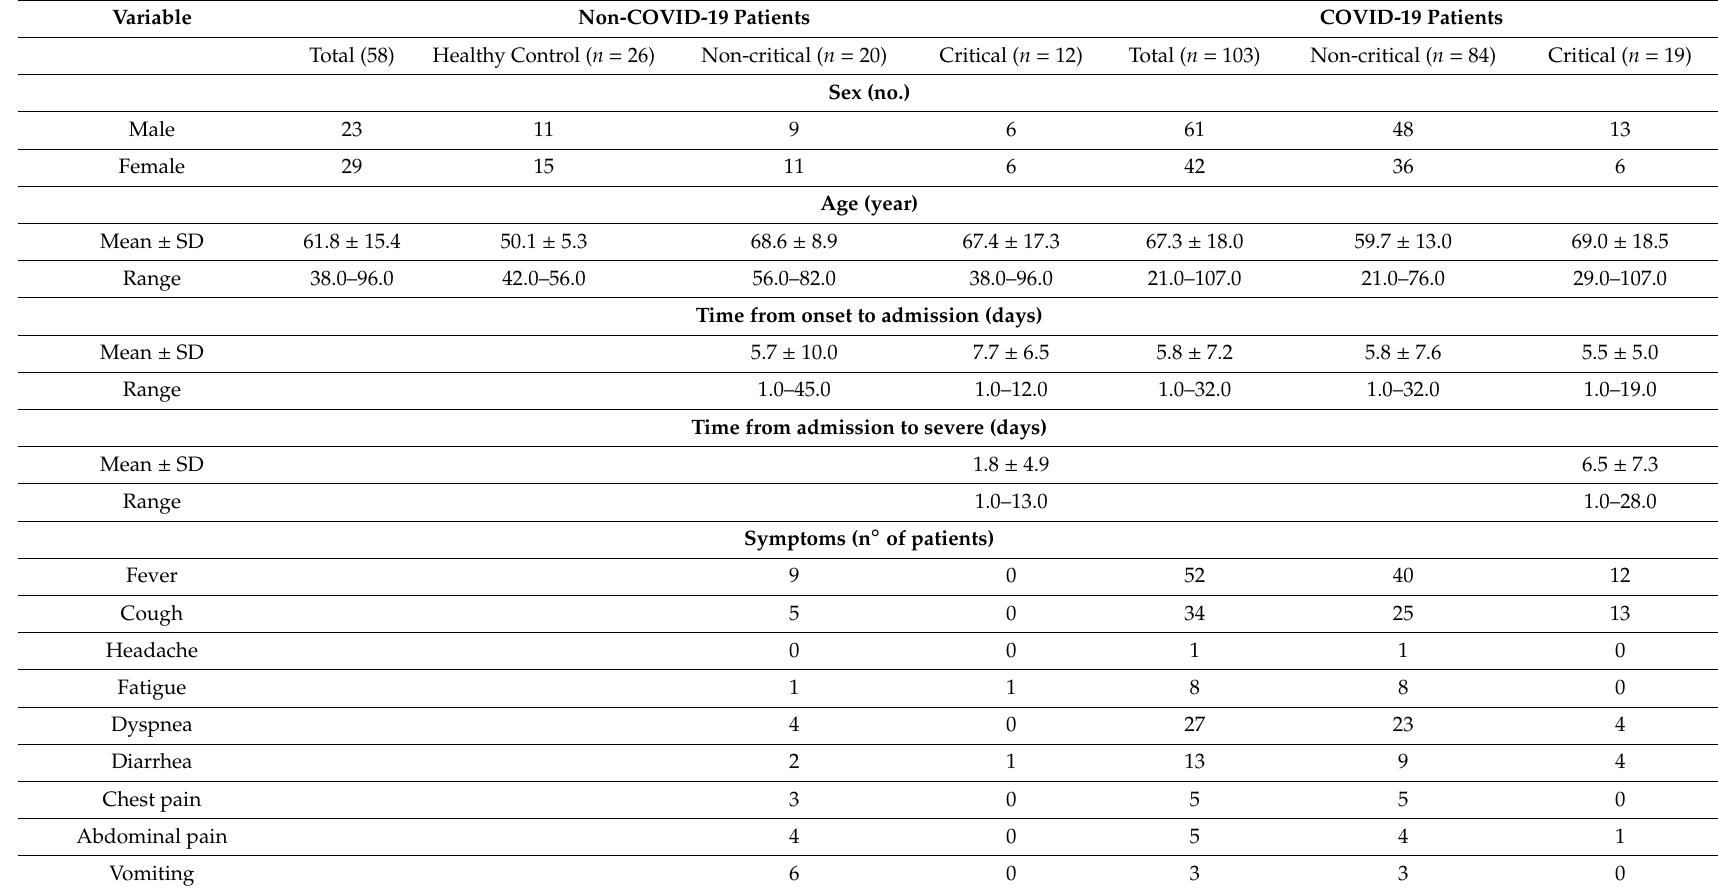
Table 1. Characteristics of the patients included in the